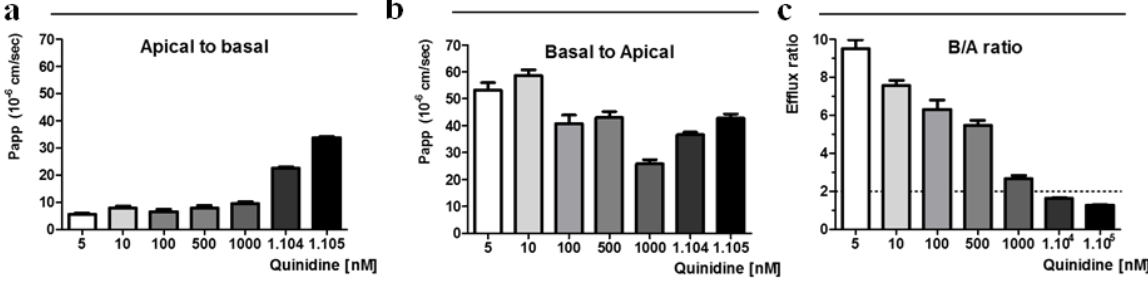
Figure 2. Effect of donor concentration on the transport of 3 H-Quinidine in Caco-2 cells. Apparent permeability was measured in two directions, ( a ) absorptive apical-to-basal (a → b) and ( b ) secretory basal-to-apical (b → a) at various donor concentrations (0.005–100 µ M). ( c ) Permeability ratio of quinidine was calculated. Data are represented as means ± s.e.m ( n = 3).